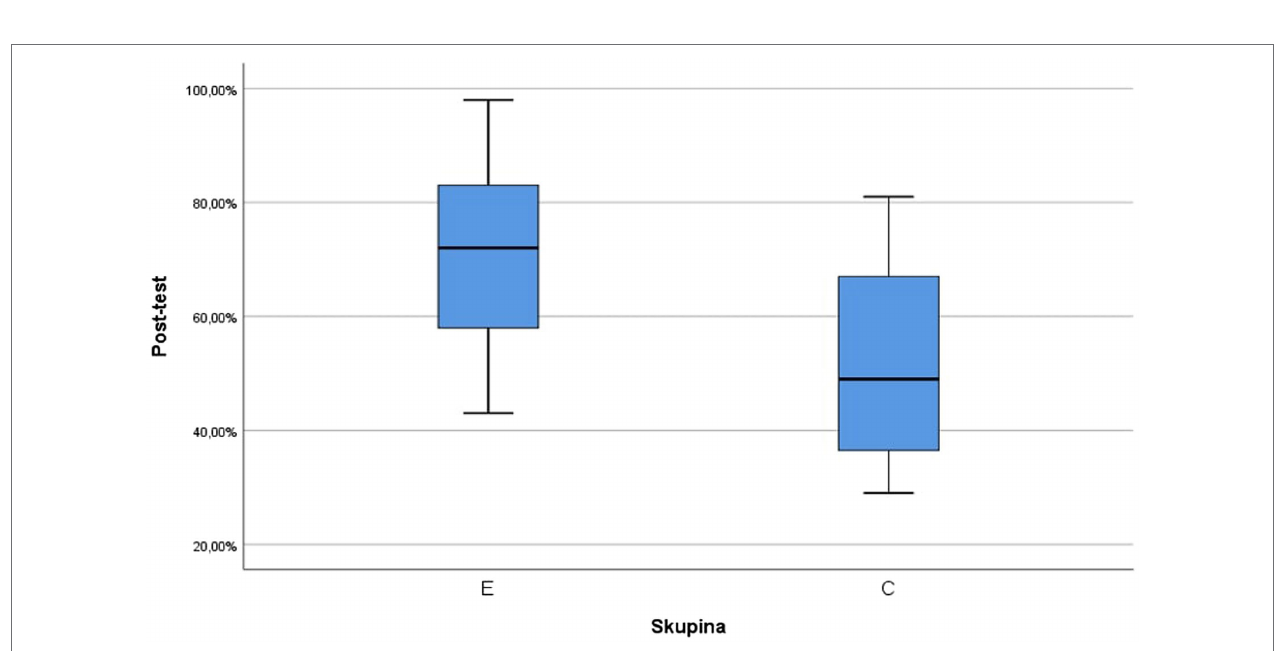
FIGURE 4 | Box diagram of pre-test results for the experimental (E) and control (C) groups.